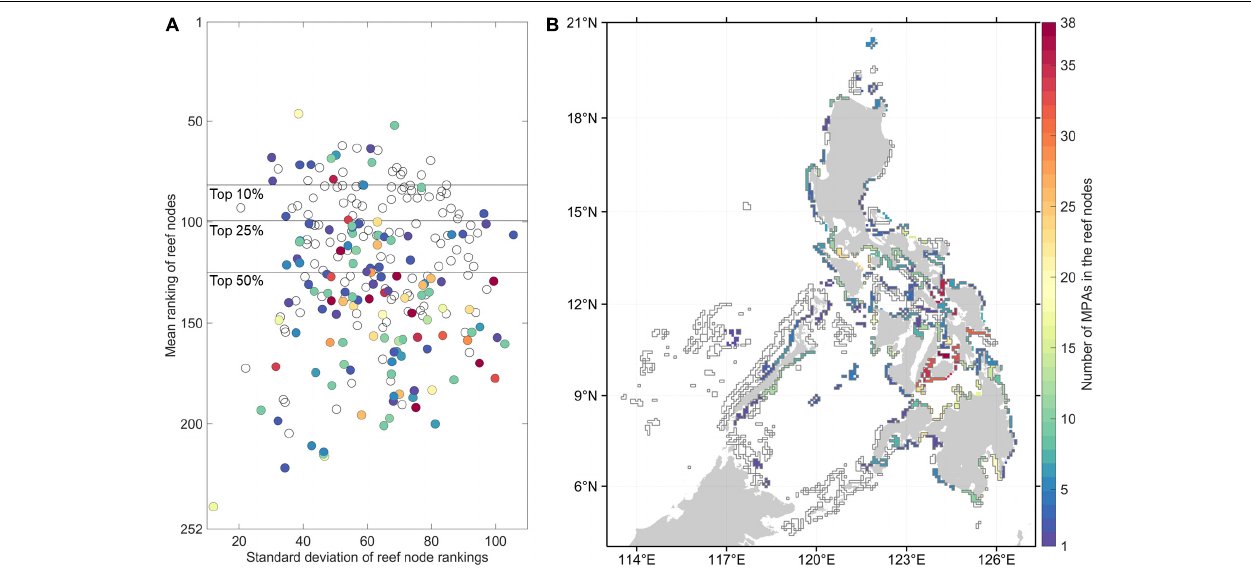
FIGURE 3 | Characteristics of the reef nodes relative to the 1,060 marine protected areas (MPAs). (A) The distribution of the overall mean rankings and their standard deviations of each reef node across indices and organisms. The horizontal lines mark the top 10, 25, and 50% mean ranking nodes. (B) Map of the reef nodes as polygons in the connectivity model. The colors in both (A,B) indicate the number of MPAs located in the reef nodes. Empty polygons indicate that there is no MPA geographic coordinate information for these reef nodes.